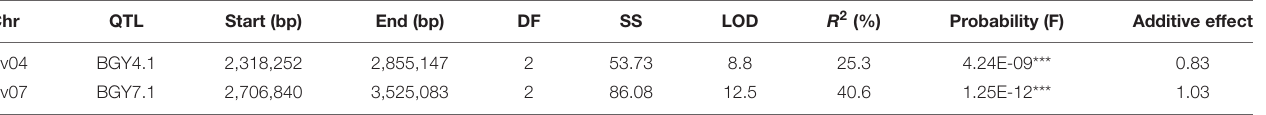
FIGURE 6 | Genetic mapping for resistance to BGYMV (1–9) evaluated in the DOR 364 x XAN 176 (DX) recombinant inbred population in Puerto Rico in spring 1994 (Miklas et al., 1996): (A) LOD profiles obtained by two-dimensional genome scans. The BGY4.1 and BGY7.1 QTL models were fitted and refined using the multiple imputation method. Dashed line denotes significance at the 0.05 probability level and (B) interaction between BGY4.1 and BGY7.1 QTL for resistance to BGYMV (see also Supplementary Figure S1 ). TABLE 4 | QTL identified in the DX RIL